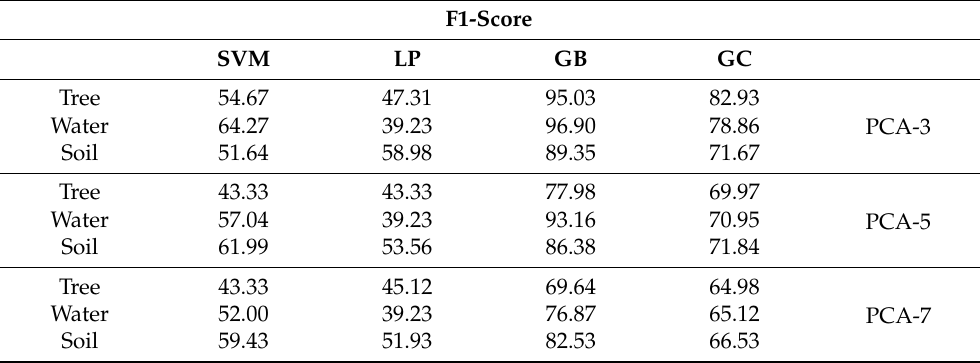
Figure 16. ( a ) Tree class reconstructed image with label 0 (blue) for pixels Not Belonging to tree class, label 1(green) for Strong Belonging pixels to tree class, and label 2 (brown) for pixels Weakly Belonging to tree class. ( b ) Water class reconstructed image with label 3 (blue) for pixels Not Belonging to water class, label 4 (green) for Strong Belonging to water class, and label 5 (brown) for pixels Weakly Belonging to water class, ( c ) Soil class reconstructed image with label 6 (blue) for pixels Not Belonging to soil class, label 7 (green) for pixels Strongly Belonging to soil class, and label 8 (brown) for pixels Weakly Belonging to Soil class, ( d ) Original groundtruth for tree class, ( e ) Original groundtruth for water class, and ( f ) Original groundtruth image for soil class. Table 8. The F1 score for classification of Jasper HSI using PCA 3, 5, and 7 bands with maximum scaling using the four